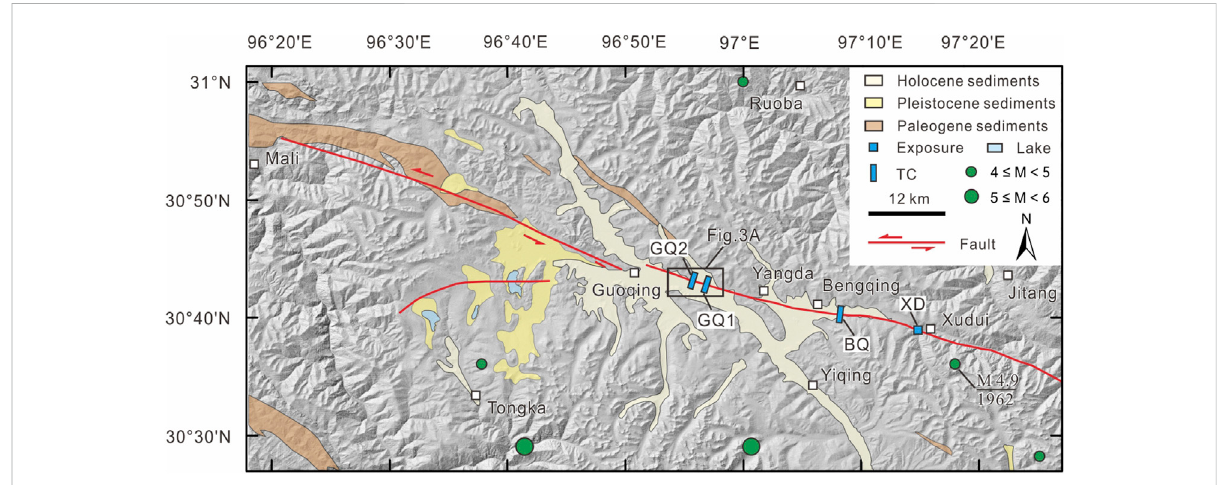
FIGURE 2 Geologic features and fault distributionof theYYF. Please refer to location inFigure 1. Geological data are adaptedfrom the 1:250000 geologic map. The hillshade map is generated from the ASTGTM (30-m resolution). The black box indicates the extent of Figure